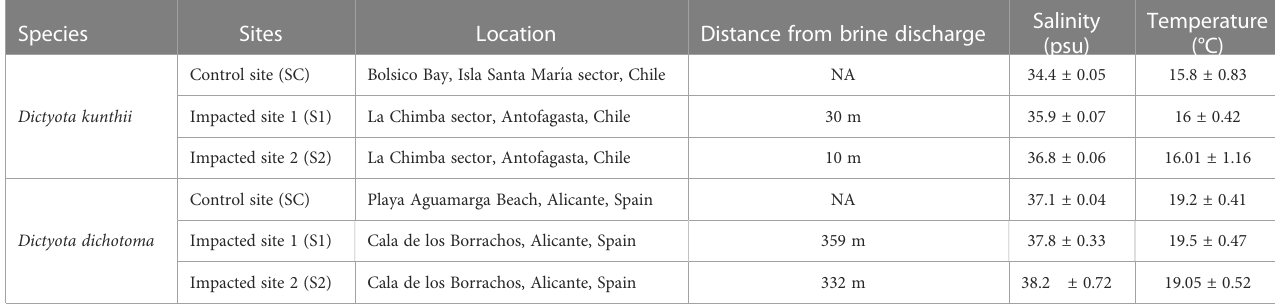
TABLE 1 Transplant site details, salinities and temperature.